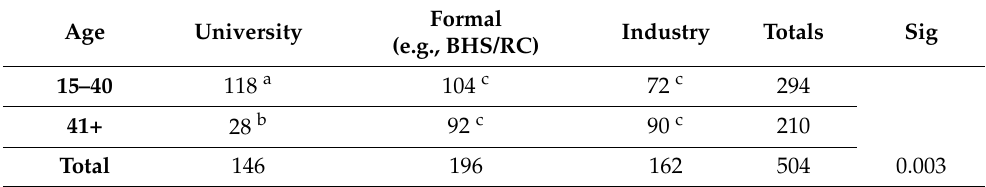
Table 1. Education status of Group 1 (15–40) and Group 2 (41+) horse owners in UK. RC = Riding Club qualifications; BHS = British Horse Society